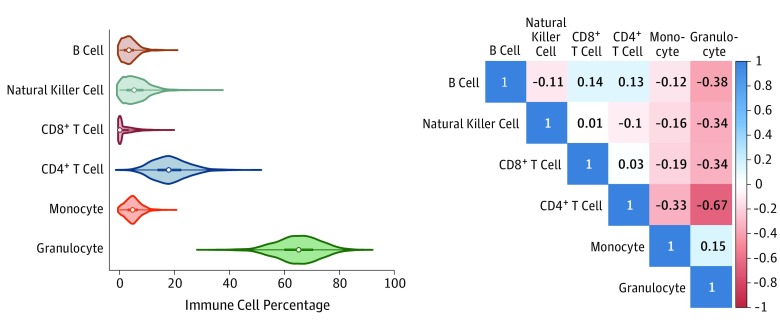
Descriptions of the Leukocyte ProportionsLeukocyte subtype distributions from the random subcohort (1295 participants) are depicted as violin plots (left panel), which represent the distribution of the values (shaded portion), median (open circle), interquartile range (thick line), and 1.5 times the interquartile range (thin line). Granulocytes were the most abundant leukocyte subtype, followed by CD4+ T cells. A Spearman correlation matrix (right panel) shows the bivariate correlations across the 6 leukocyte subtypes (B cells, natural killer cells, CD8+ T cells, CD4+ T cells, monocytes, and granulocytes). Granulocytes were inversely correlated with the lymphocyte subtypes (B cells, natural killer cells, and CD8+ and CD4+ T cells) and were positively correlated with monocytes.